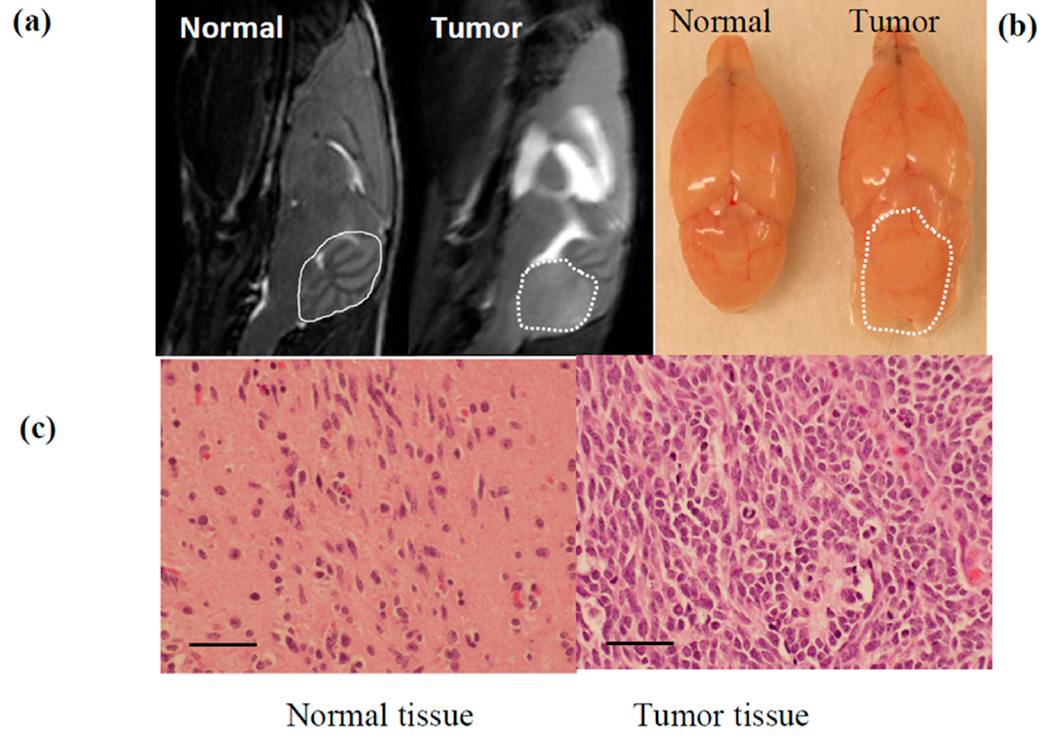
Figure 3. Pilot experiment to confirm MB in SmoA1 mouse is identified by MRI. ( a ) MRI scan of 12 week old SmoA1 mice demonstrating a normal brain (entire cerebellum circled in solid line) compared to mouse with MB in cerebellum (tumor circled in dash line) allowing for tumor volumes measurement prior to treatment ( b ) Dissected brain tissue showing the gross presence of MB tumor in the cerebellum (circled). ( c ) Histological evaluation by H&E straining confirming cellular architecture and confluence of sheets of small round blue tumor cells. Scale bar: 50 µ